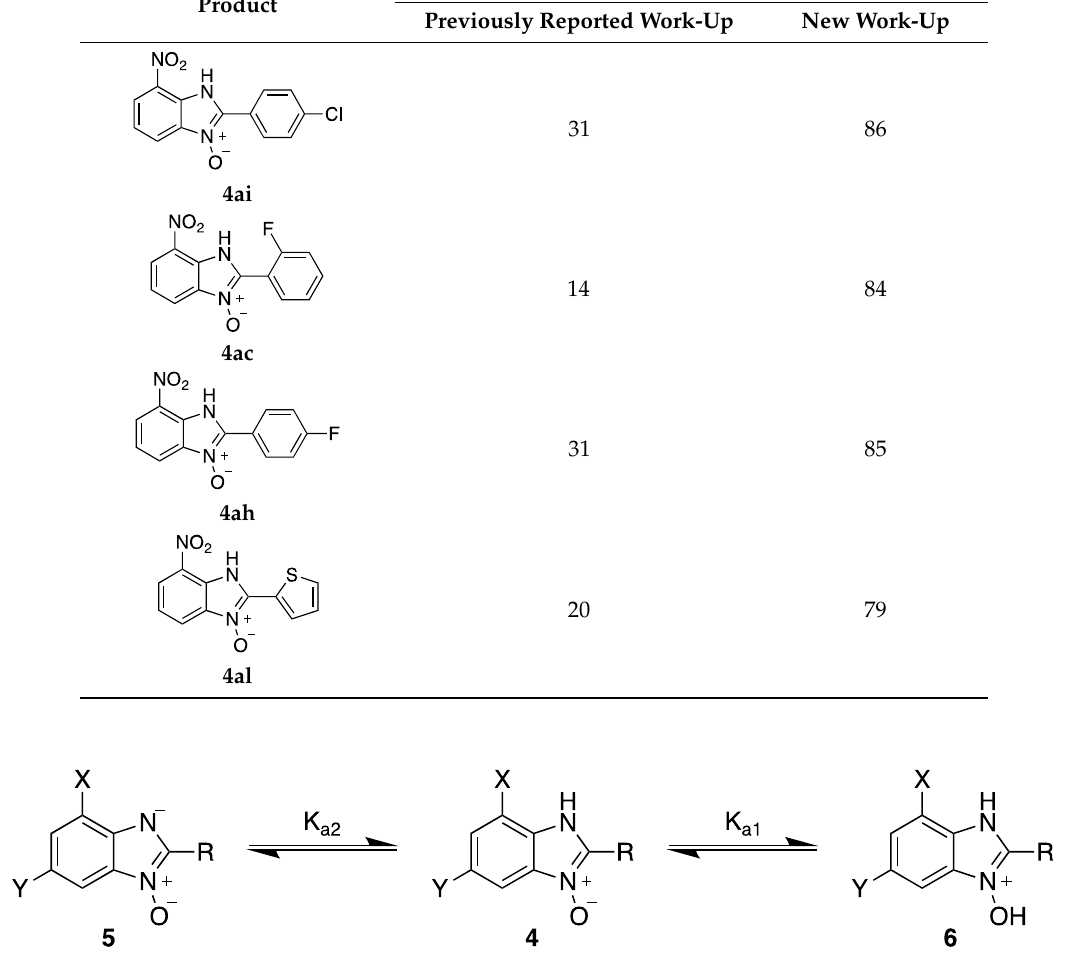
Table 1. Comparative isolated yields obtained for four representative products using the previous and improved work-up